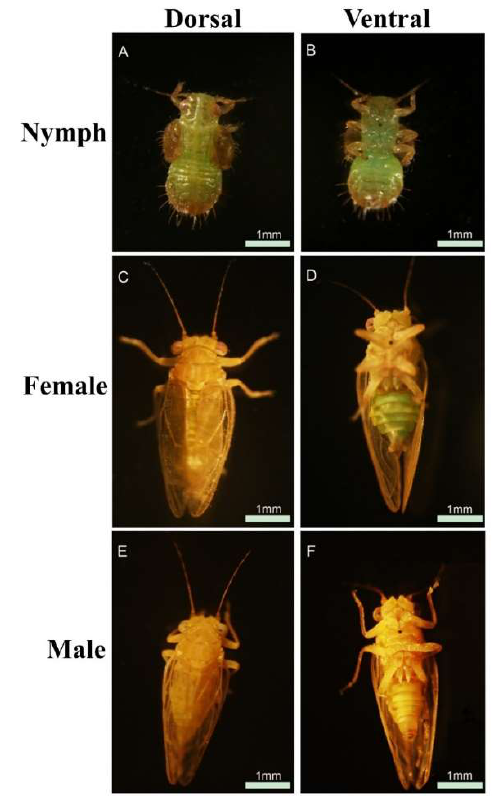
Figure 1. Photographs of Cacopsylla chinensis .